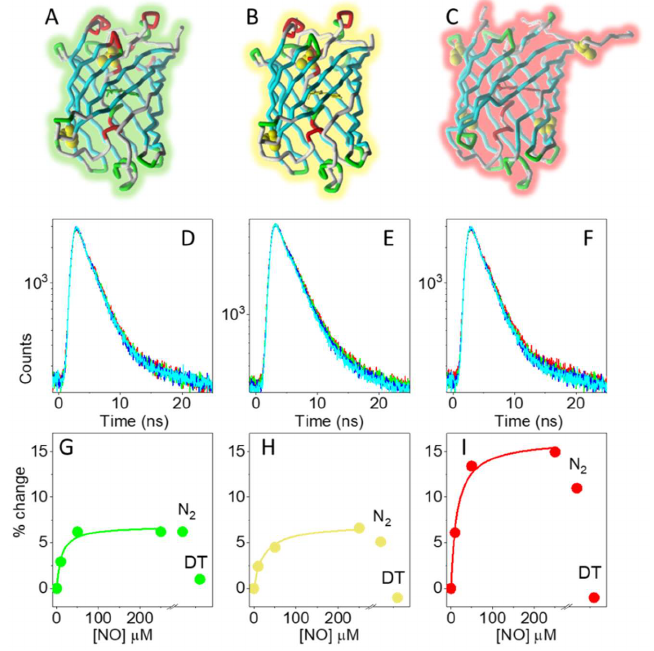
Figure 3. Schematic structures of EGFP ( A ), pdb code 2y0g), EYFP ( B ), pdb code 1YFP), and TagRFP-T ( C ), pdb code 5jva). Cys residues are displayed as yellow CPK, and chromophores are displayed as sticks. Lower panels show the fluorescence decays measured at different concentrations of NO: N 2 saturated (red), [NO] = 10 µM (green), [NO] = 50 µM (blue), and [NO] = 250 µM (cyan). ( D ) EGFP. ( E ) EYFP. ( F ) TagRFP-T. Percent changes in fluorescence lifetimes for the three proteins as a function of [NO] are plotted in ( G ) EGFP, ( H ) EYFP, and ( I ) TagRFP-T. The plots also show the effect of N 2 saturation for 1 h (N 2 ) and the subsequent reduction with Na dithionite (DT). The solid lines are the result of the fits of the lifetime data with a model for binding a small ligand (NO) to the macromolecule.